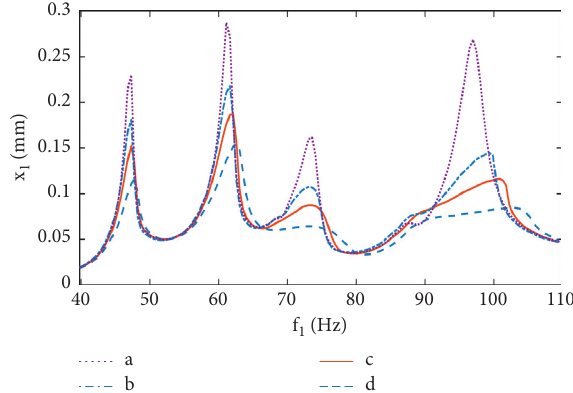
Figure 11: Amplitude-frequency curves when front high-pressure SFD is implemented (a: no SFD, b: 0.25mm, c: 0.20mm, d: